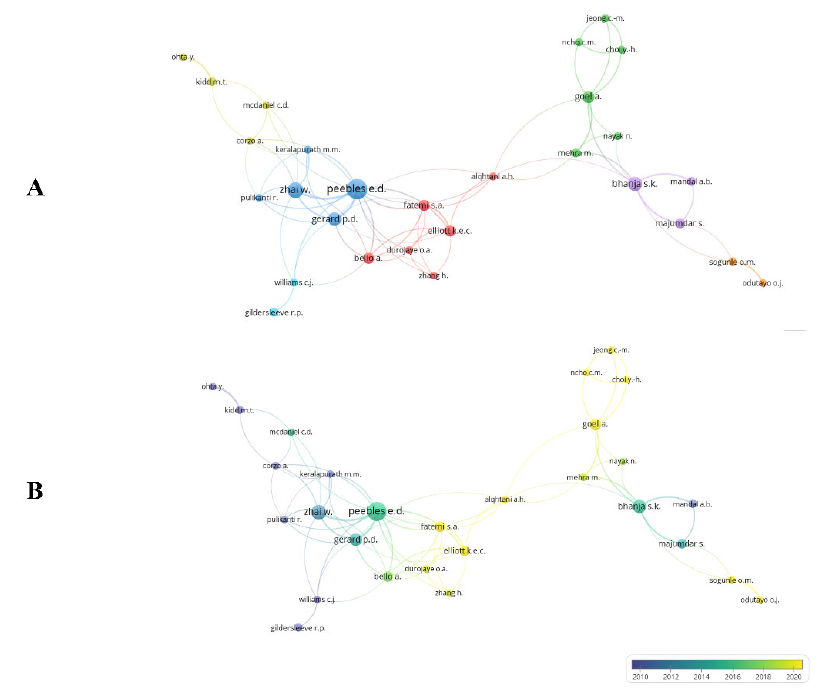
Figure 7. Network of authors based on numbers of citations.